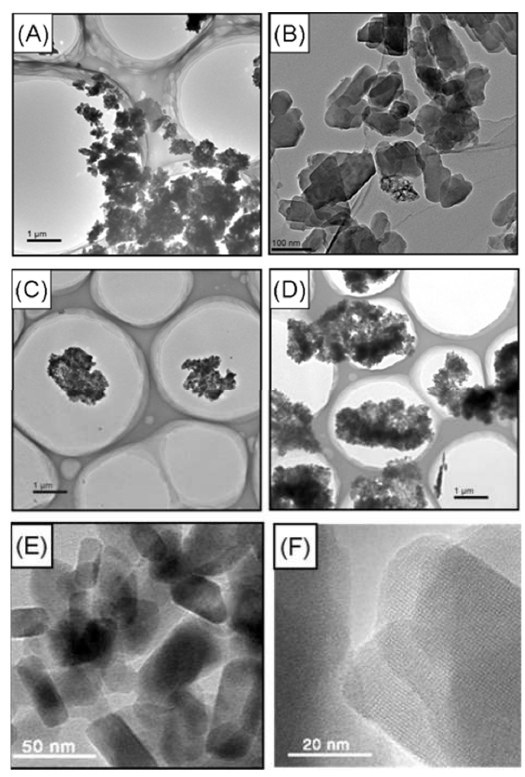
Figure 12. The HRTEM images of agglomerated zeolite ZSM-5 with different particle size: ( A ) 0.2–4 μm [59], ( B ) 0.2 μm [59], ( C ) 1 μm [59], ( D ) 4 μm [59], ( E , F ) 20–50 nm [55].